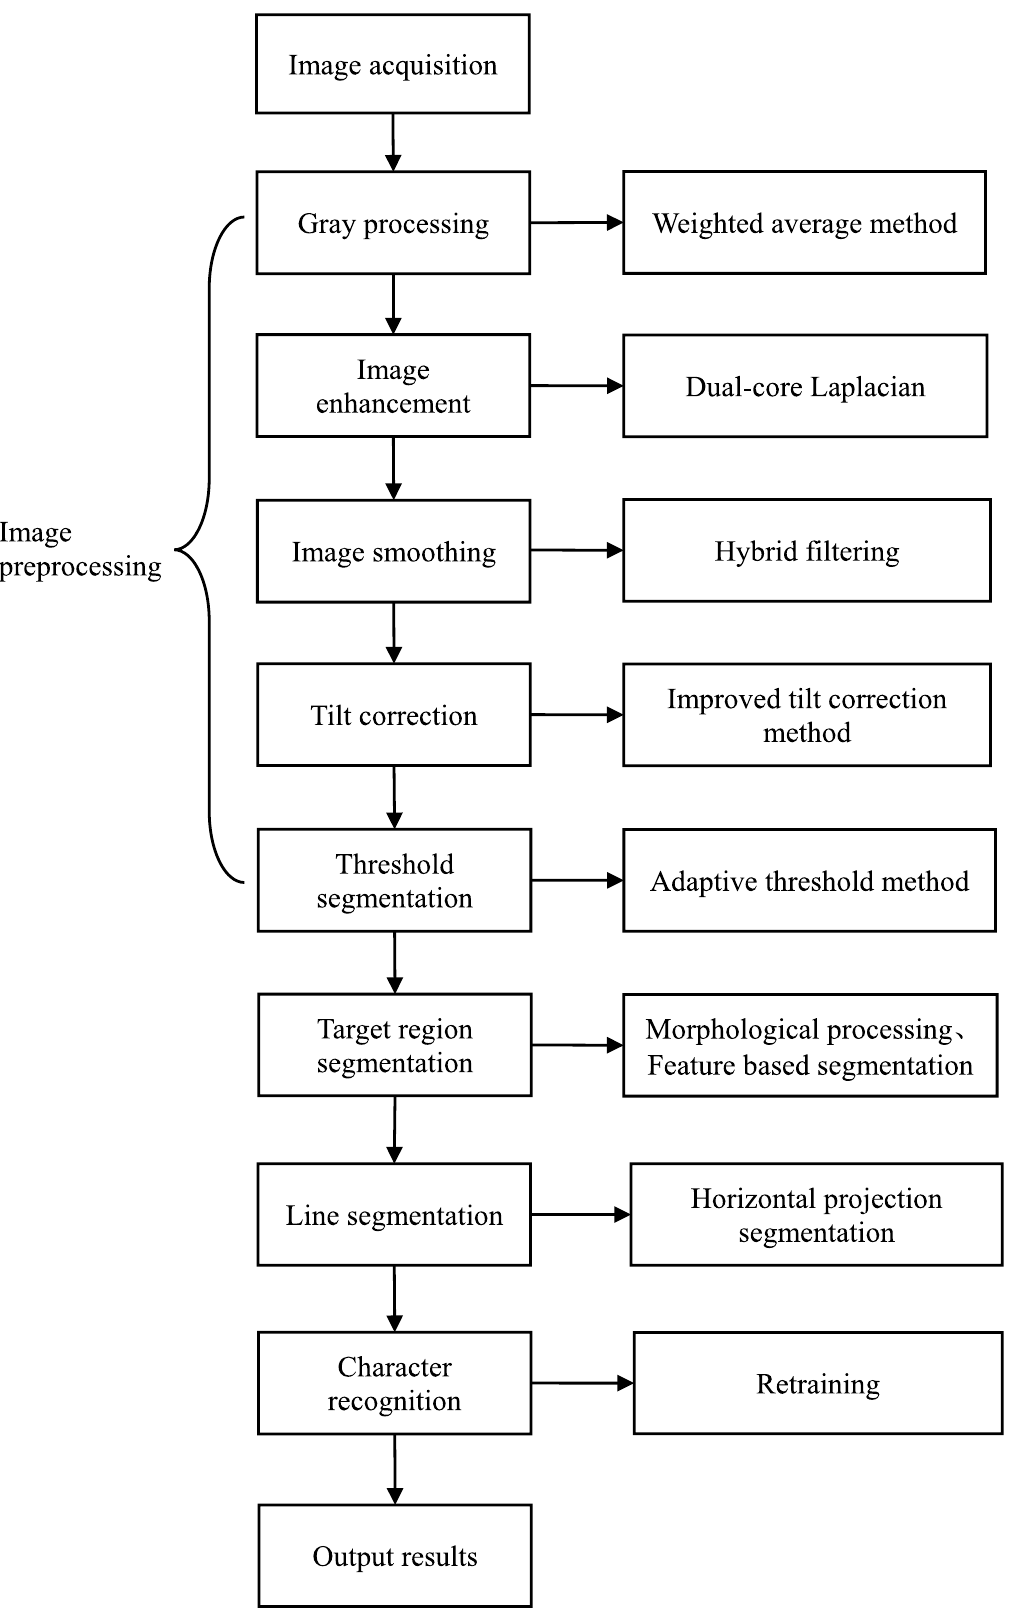
Fig. 5 Frame diagram of axle end marks character